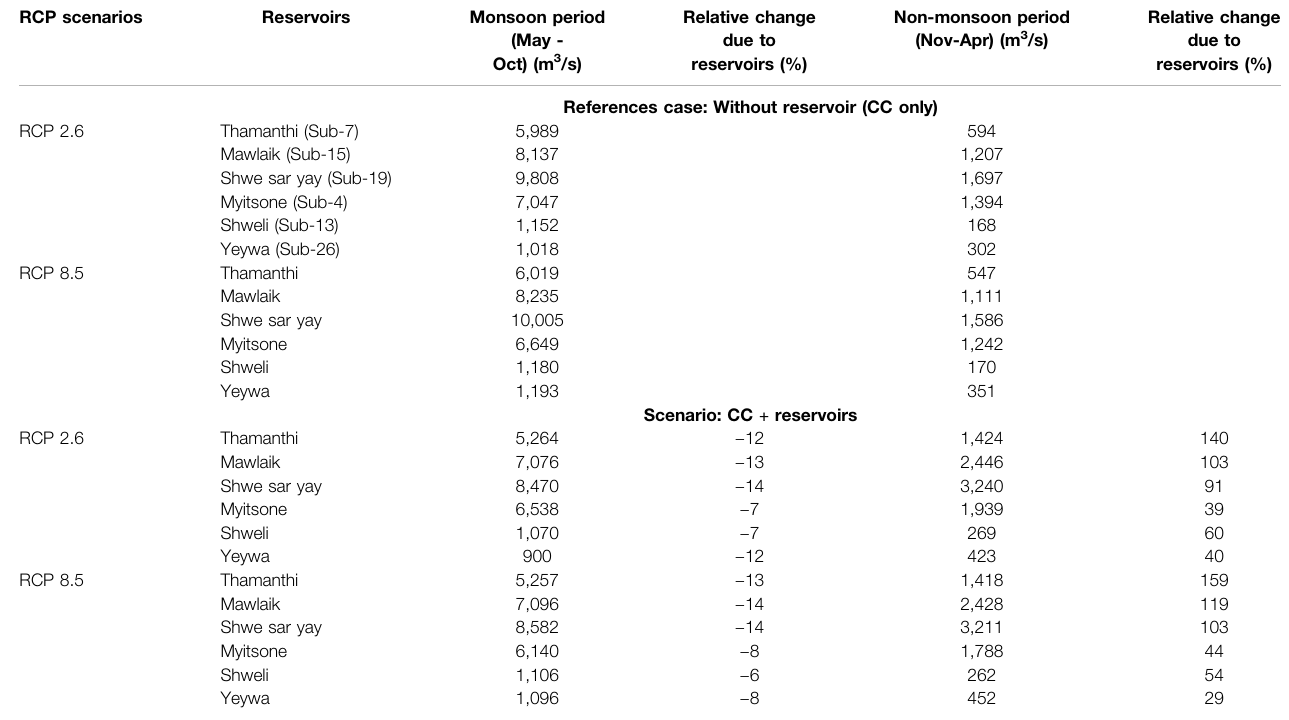
TABLE 4 | Changes in projected seasonal stream fl ow just downstream of each reservoir during the end-century period (2081 – 2100) under RCP 2.6 and RCP 8.5 for the simulationsforcedwithCSIROMk3.6,withandwithoutreservoirs.Thecorrespondingclimatechangeforcedsimulationwithoutreservoirsisconsideredasthereference case when computing relative changes of projections obtained with the inclusion of reservoirs. It was assumed that all the reservoirs are at their maximum water level at the beginning of all